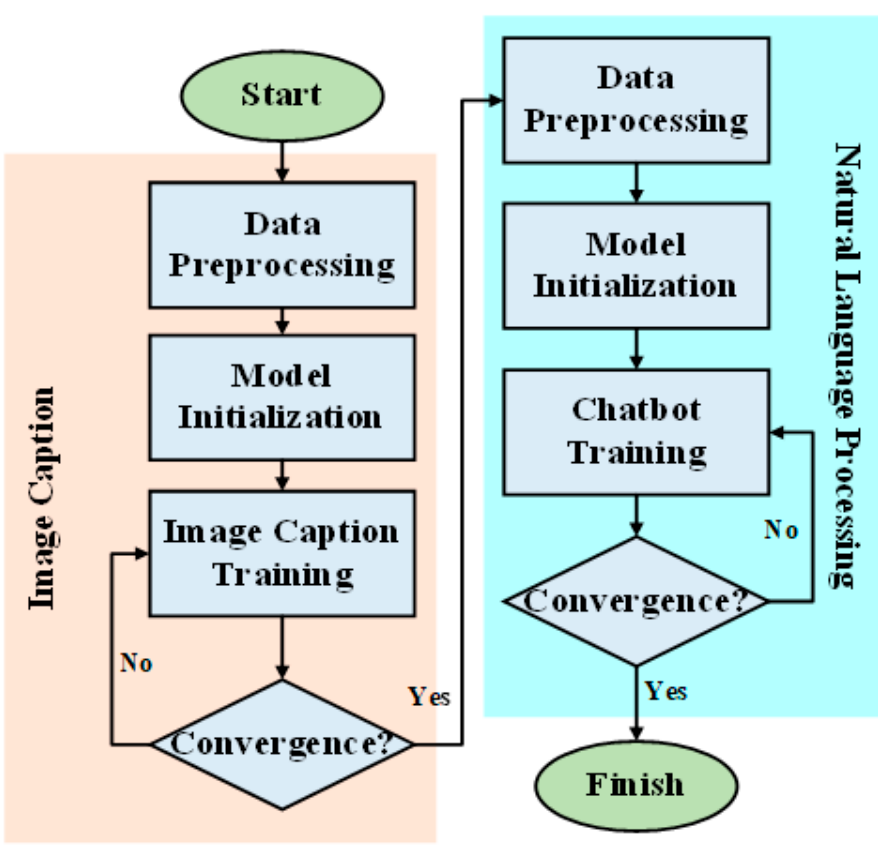
Figure 9. System flowchart of the training process.